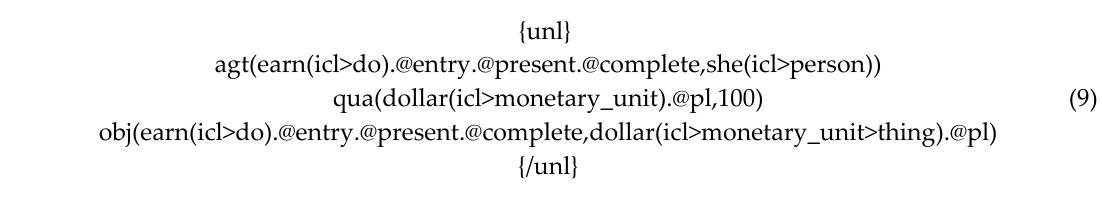
Figure 5. Representation of matrix for (N1 L N2) structure.